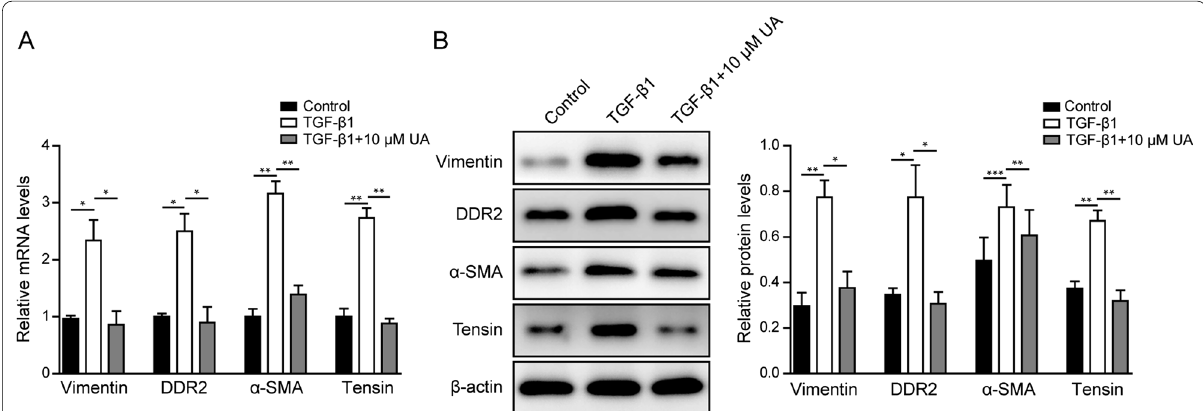
Fig. 2 UA treatment repressed TGF-β1-induced transformation of cardiac fibroblasts to myofibroblasts. A The mRNA and B protein levels of vimentin, DDR2, α-SMA and tensin in CFs after indicated treatments. β-actin was used as normalized control.